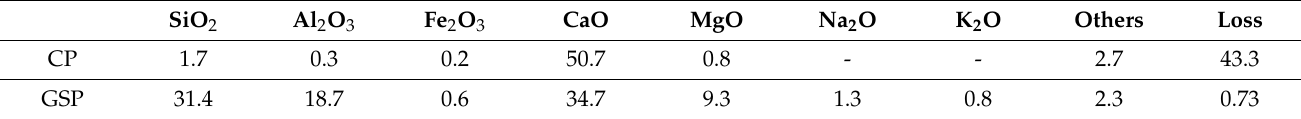
Table 1. Chemical composition (%).